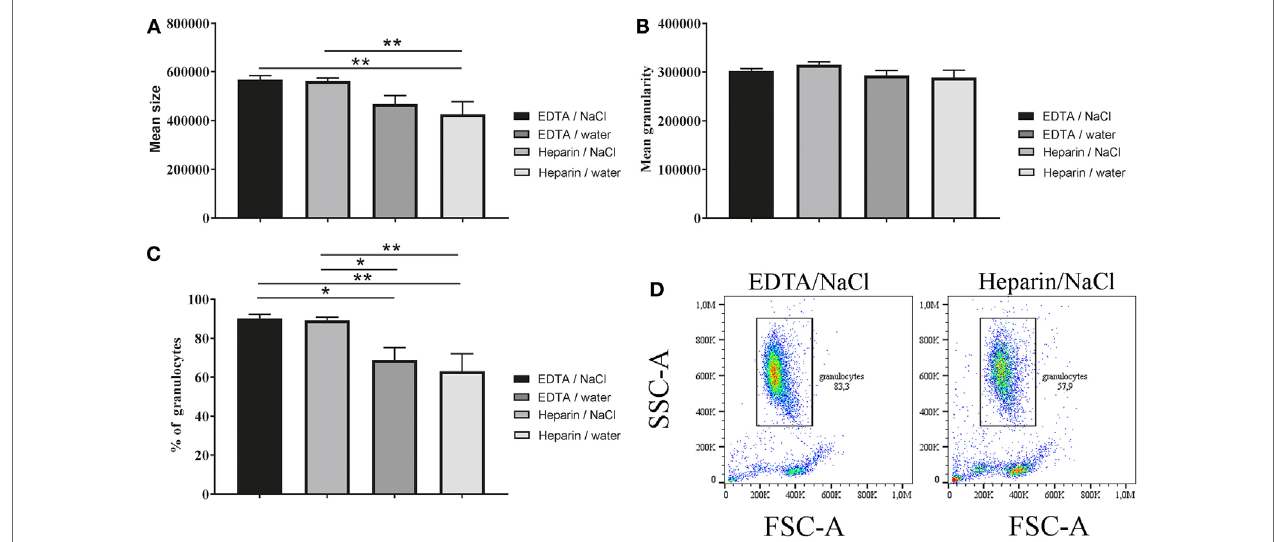
FIGUrE 3 | Morphology (size and granularity) of harvested cells and percentage of granulocytes. Harvested unstained cells were analyzed by flow cytometry. (A) Mean size of unstained cells based on forward scatter/area of intensity (FCS-A) was significant different ( n = 5, one-way ANOVA P = 0.0027). (B) Mean granularity of unstained cells based on sideward scatter/area of intensity (SSC-A) was not significant different ( n = 5, one-way ANOVA P = 0.1223). (c) Percentage of granulocytes was calculated based on FSC-A and SSC-A level and showed significant differences between K 3 EDTA and lithium heparin ( n = 5, one-way ANOVA P = 0.0011). (D) Scatter blots as presented were used throughout whole experiments for subsequent data analysis. One-way ANOVA was followed by Tukey’s multiple comparisons test. P values * P < 0.05 and ** P < 0.01 were considered significant.